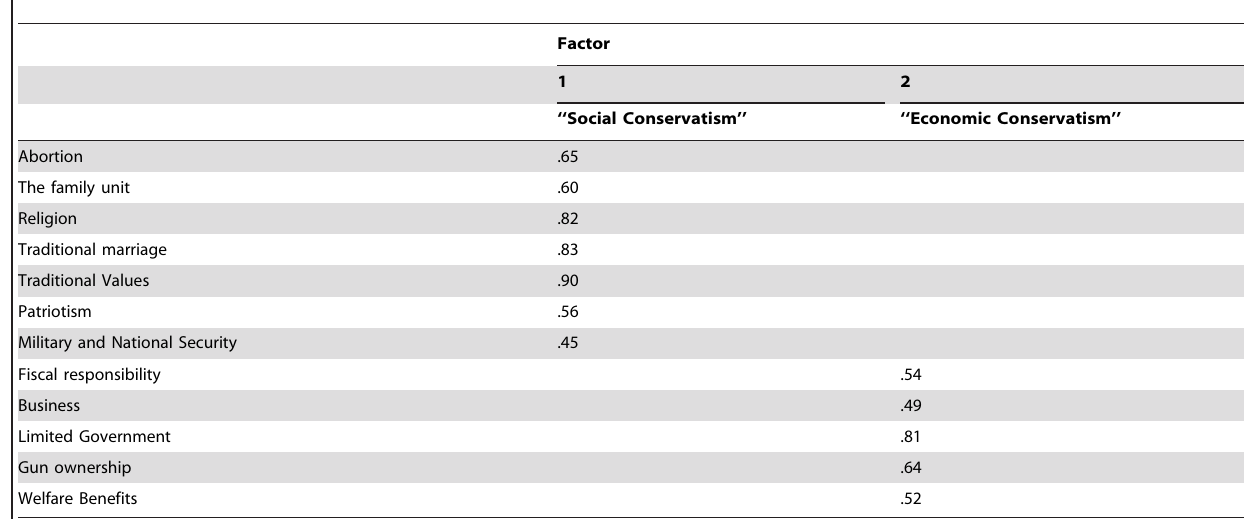
Table 4. Pattern Matrix using Principal Axis Factoring (PFA) to extract two factors with Direct Oblimin Rotation.